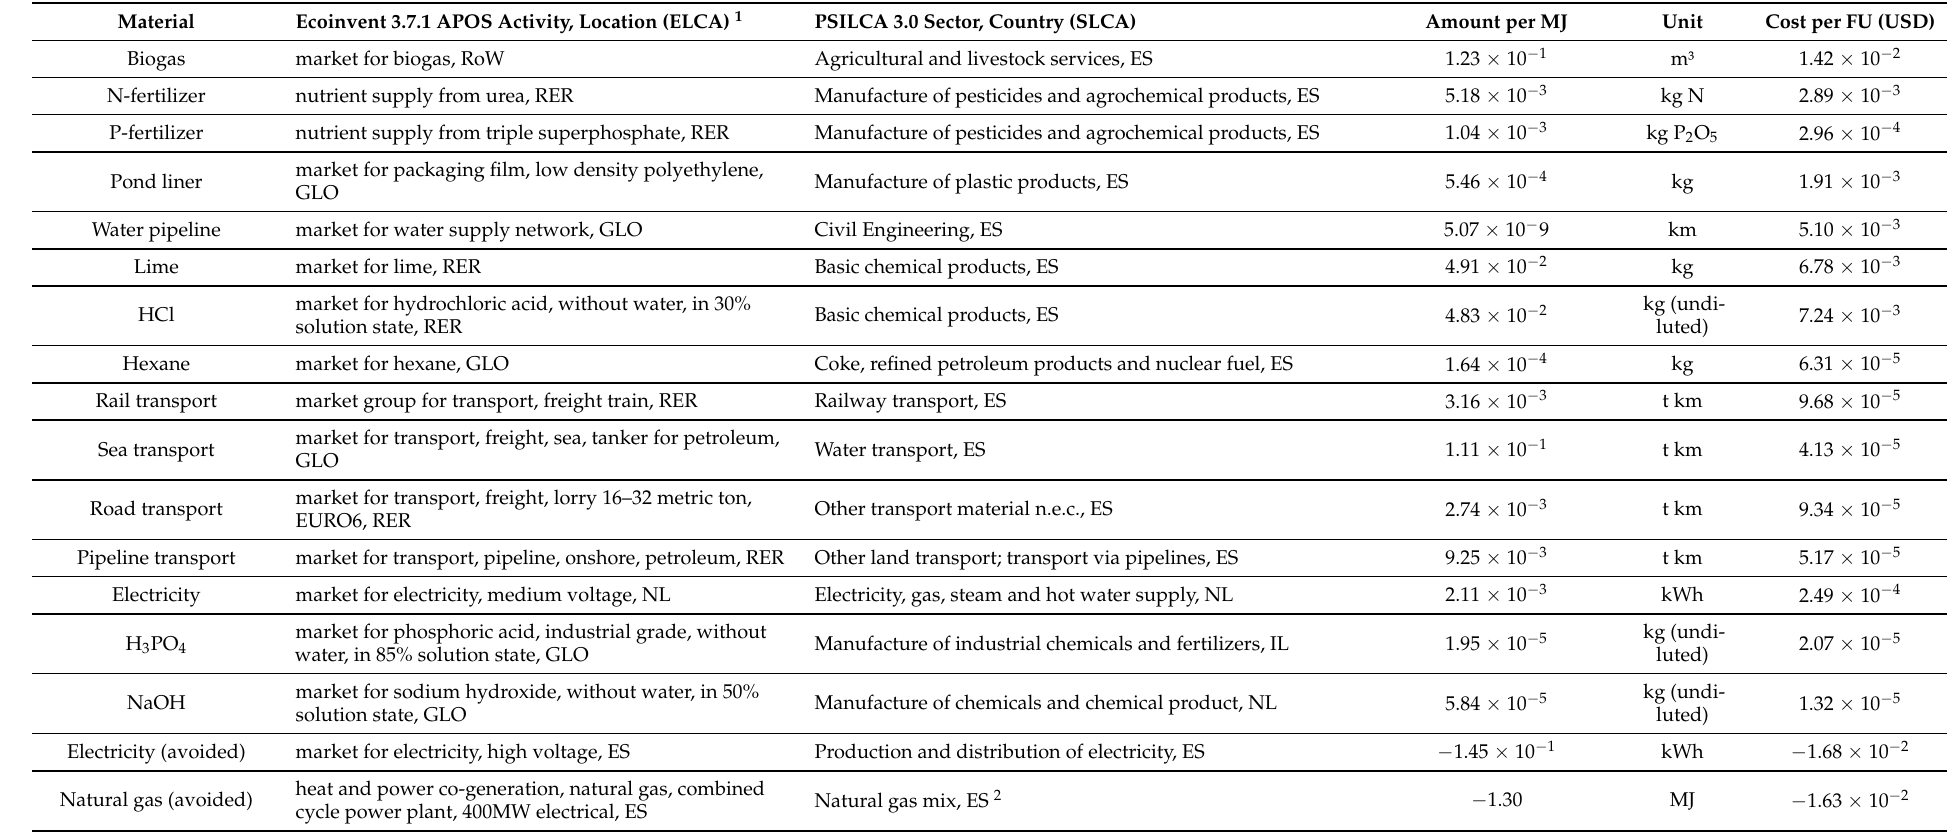
Table 1. Inventory of the AF + energy scenario (adapted from Portner et al.